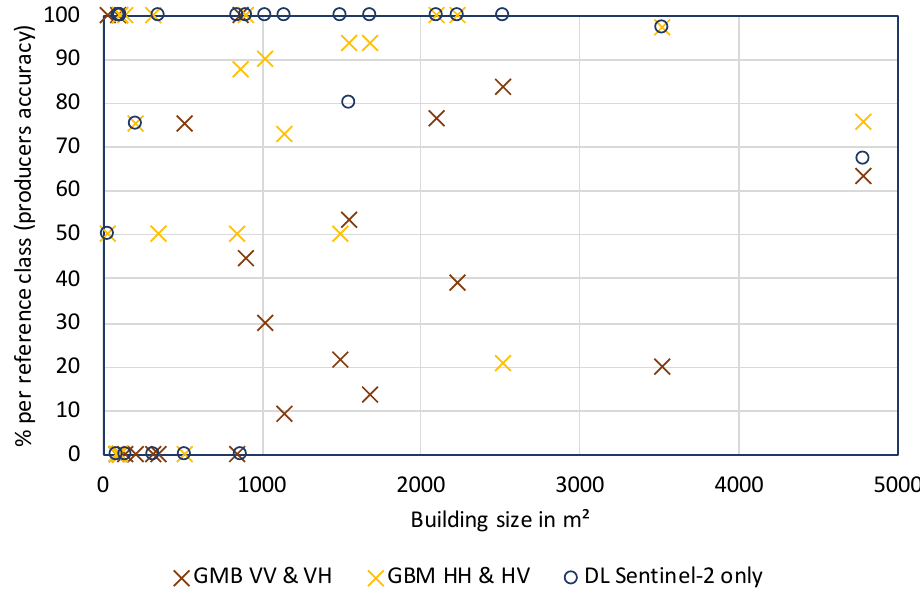
Figure 12. Classification performance results for surface types for Greenland (validation data source [60]). DL—Deep Learning, GBM—Gradient Boosting Machines, V—vertical polarization, H—horizontal polarization.